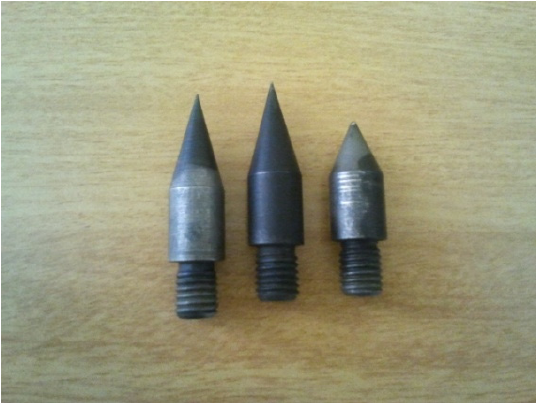
Figure 9. Sharp impactors used in this study.